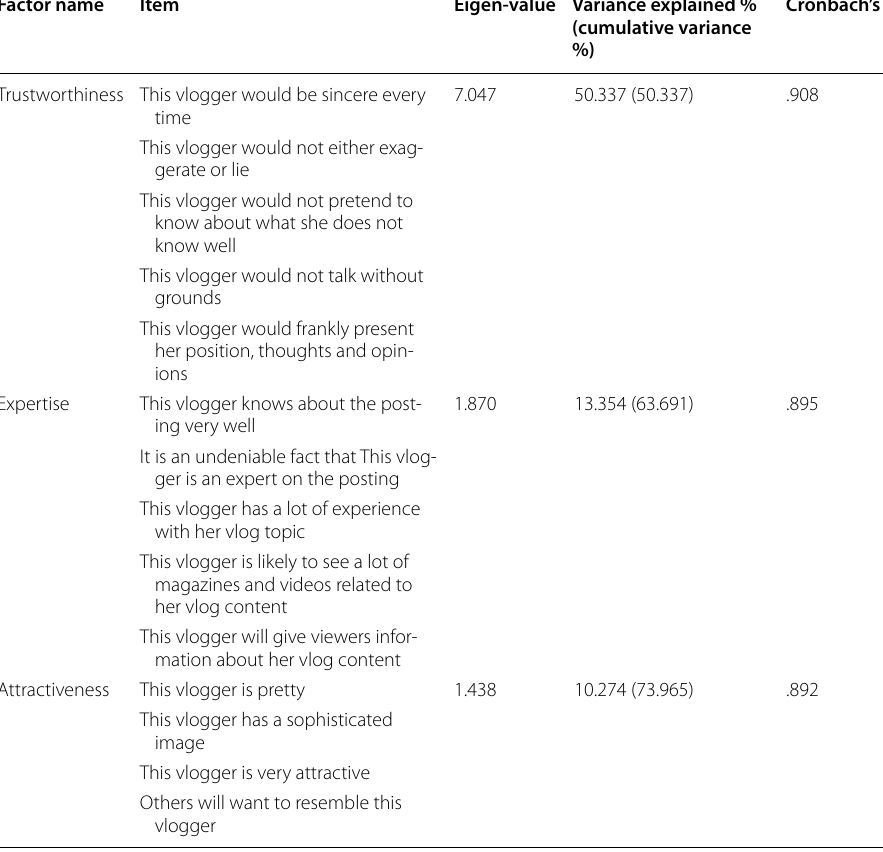
Table 1 The result of principal factor analysis for vlogger’s attributes Factor